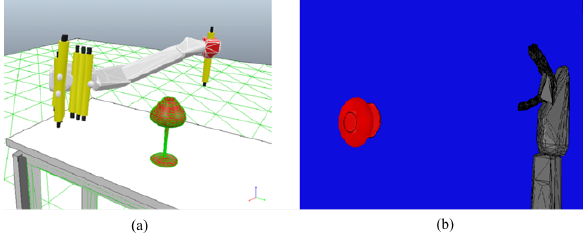
Figure 7: The raw motor output (a) and raw sensory input (b) con- sidered in the learning-to-grasp experiment. Yellow cylinders in (a) refer to the axes of rotations of the joints controlled during grasp